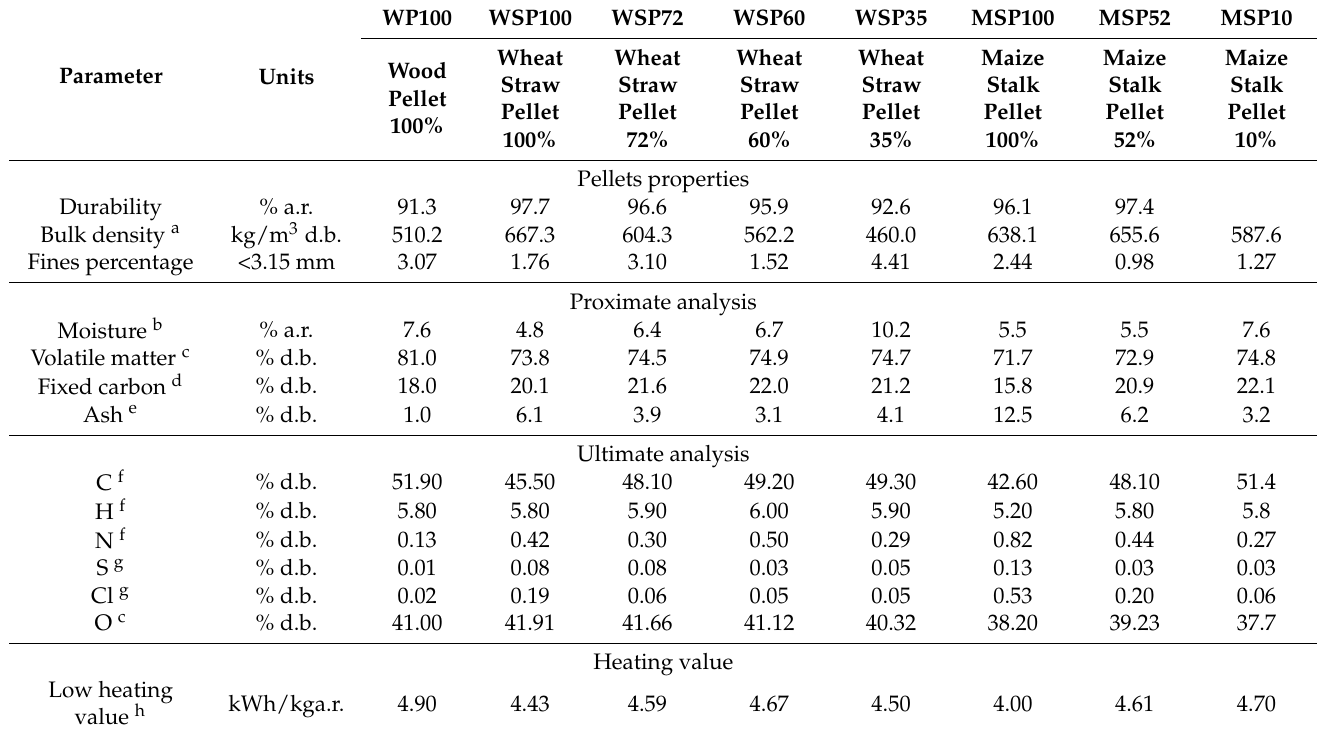
Table 2. Fuel properties (% a.r.: weight percentage as received; % d.b.: weight percentage in dry